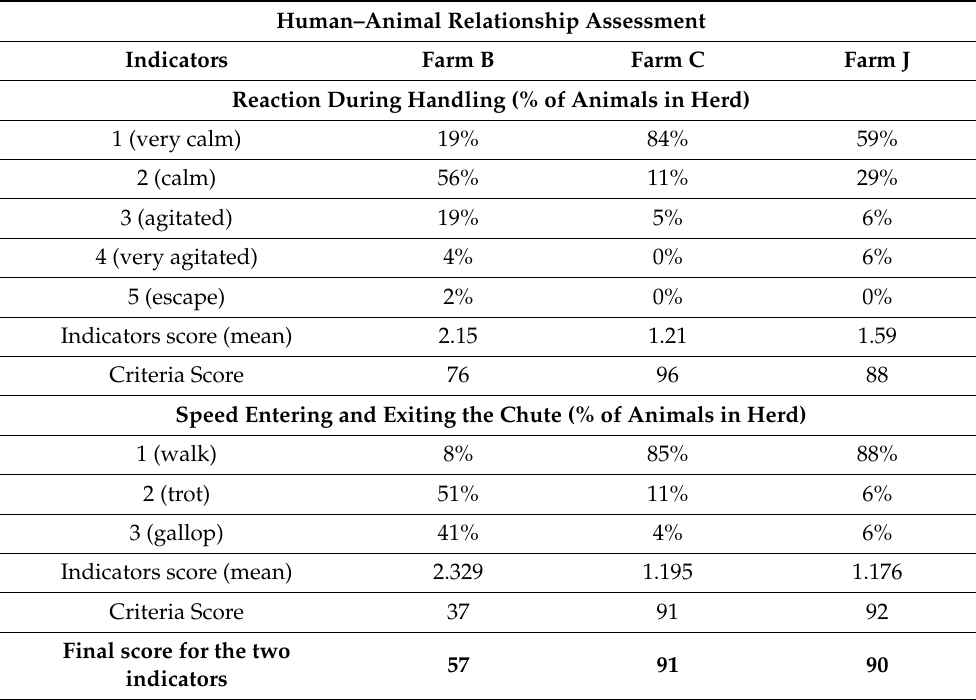
Table 3. Scoring of the three farms in reaction to handling and in speed at entry and exit from chute. Human–Animal Relationship Assessment